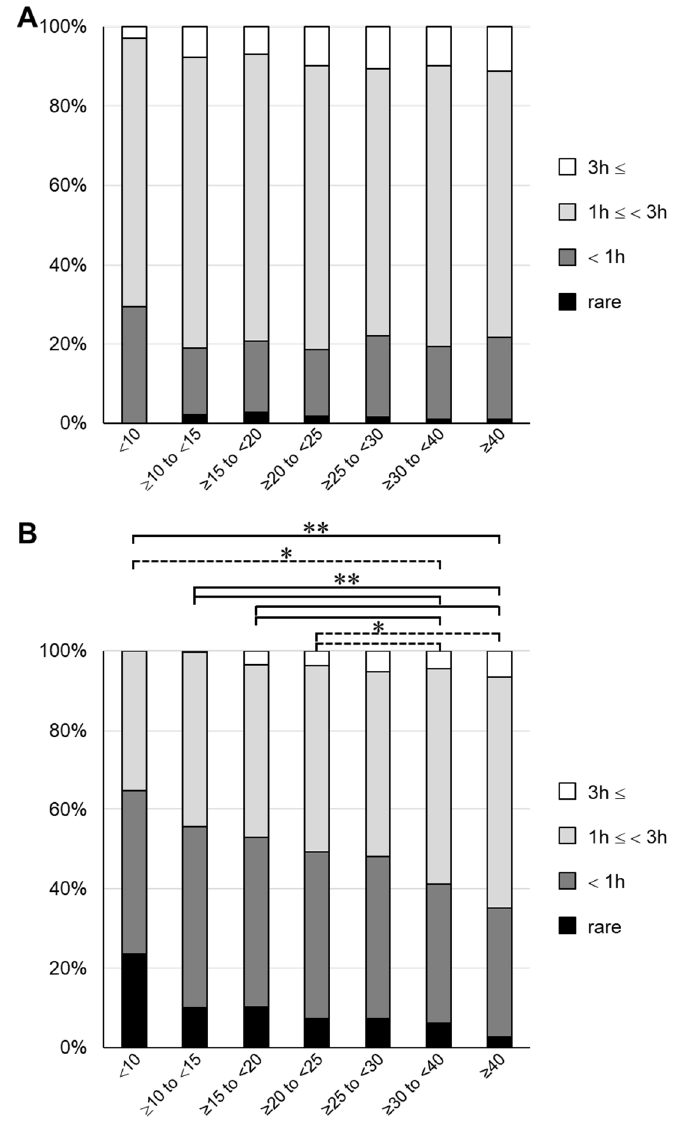
Figure 4. Outdoor playing time for each group divided by serum 25(OH)D3 concentration 3 h:3 h; 1 h:1 h; rare: answer indicating that they rarely play outside. ( A ) Summer. ( B ) Winter. Dashed line, * p < 0.05; solid line, ** p < 0.01.